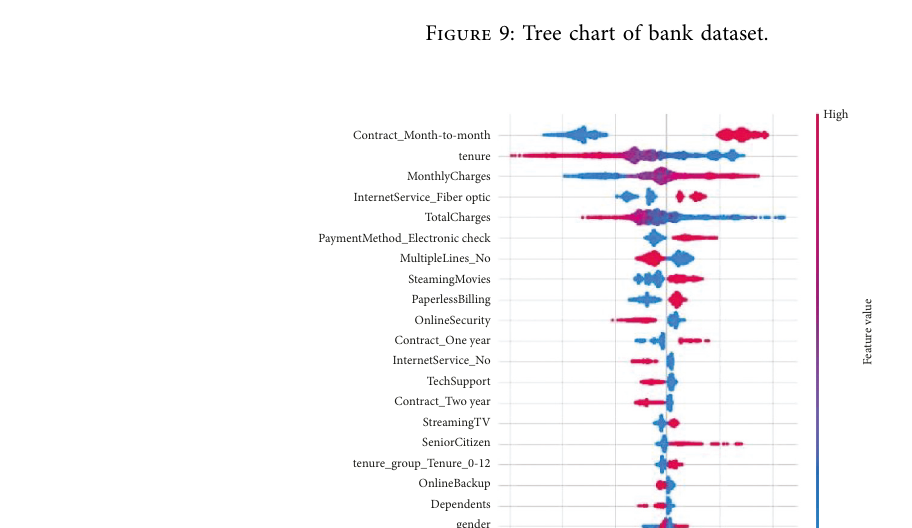
Figure 9: Tree chart of bank dataset.